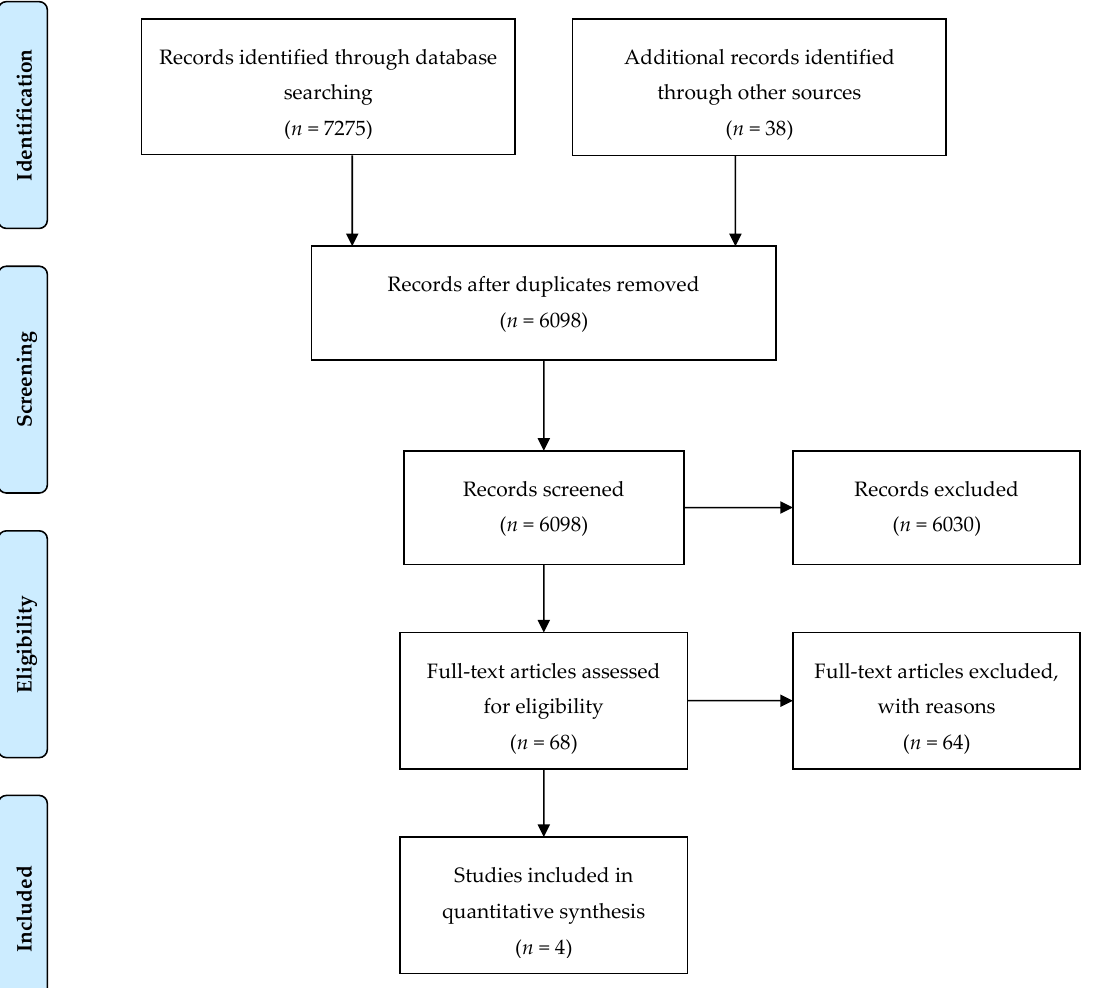
Figure 1. Preferred Reporting Items for Systematic Reviews and Meta-Analyses (PRISMA) diagram of study